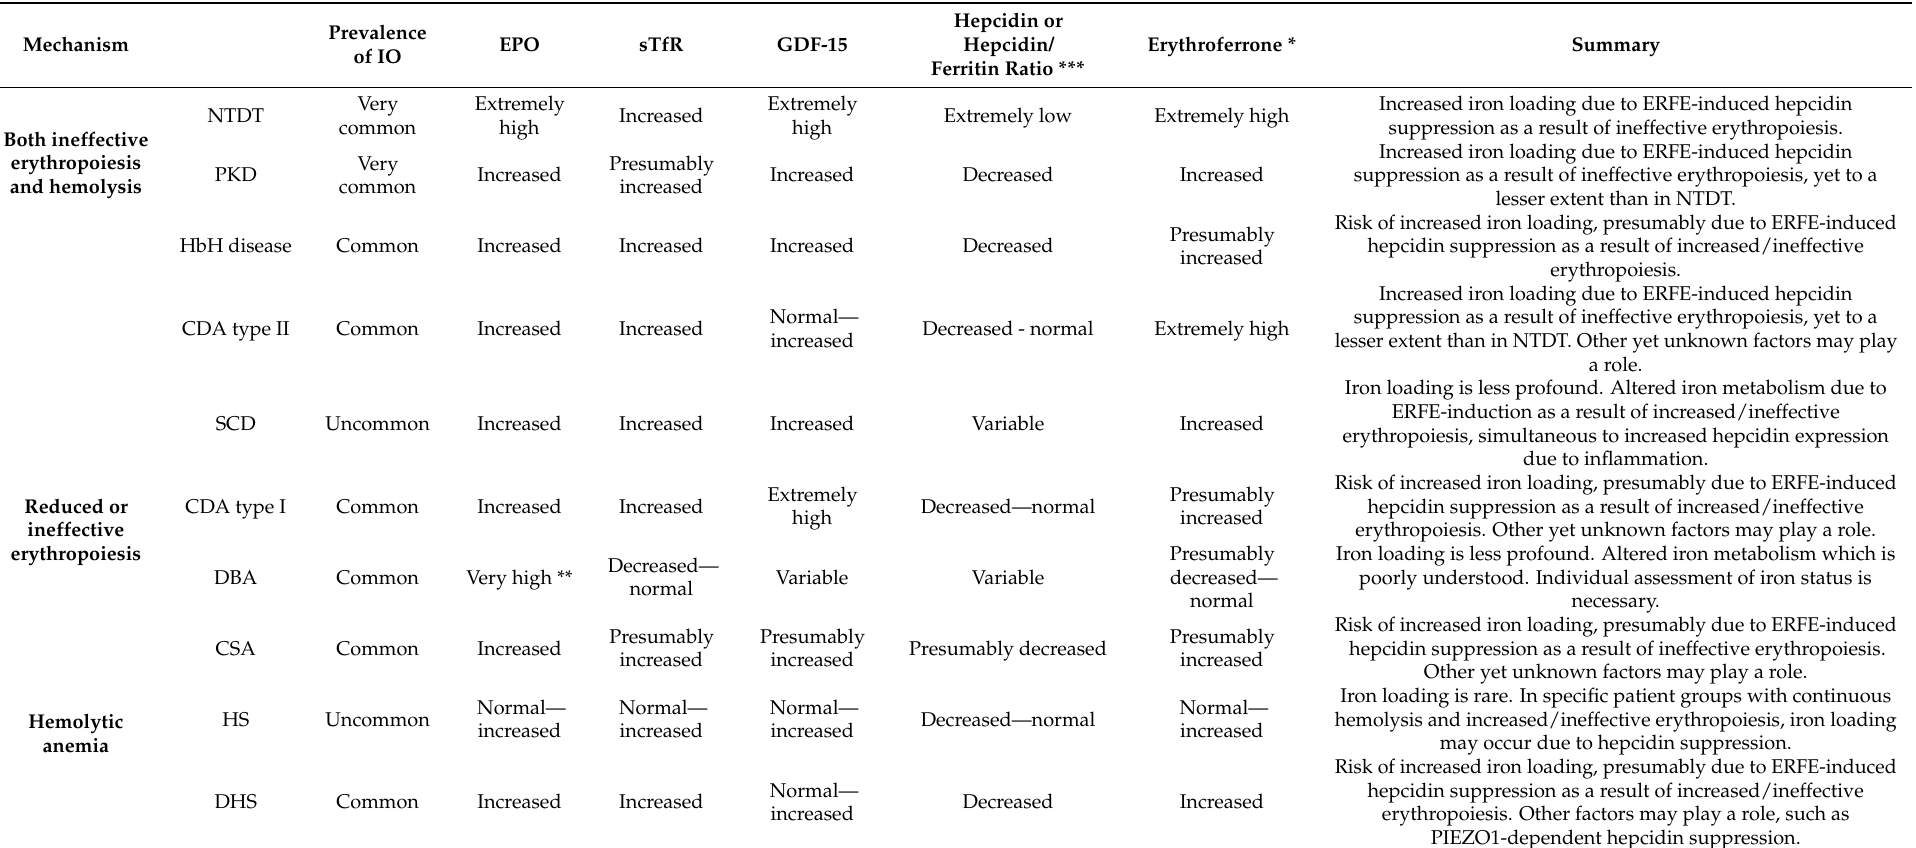
Table 2. Overview of proposed mechanisms in the various types of rare hereditary anemia. CDA congenital dyserythropoietic anemia; CSA congenital sideroblastic anemia; DBA Diamond-Blackfan anemia; DHS dehydrated hereditary stomatocytosis; EPO erythropoietin; GDF-15 growth differentation factor 15; HS hereditary spherocytosis; IO iron overload;